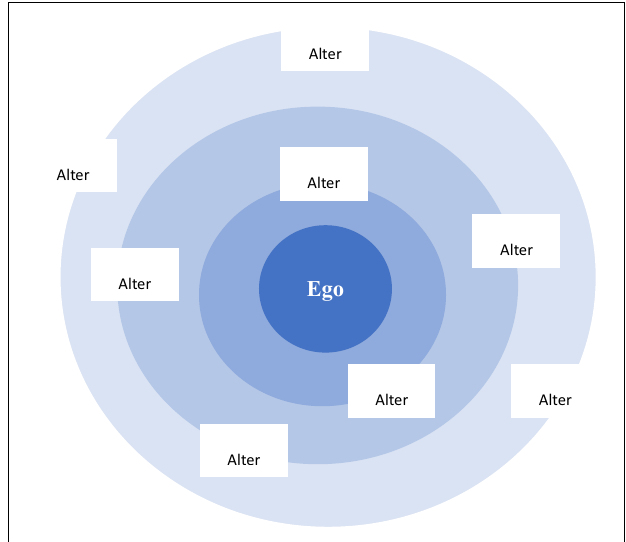
FIGURE 1 | Adapted from concentric circle (CC)map. Source: Van Waes et al.